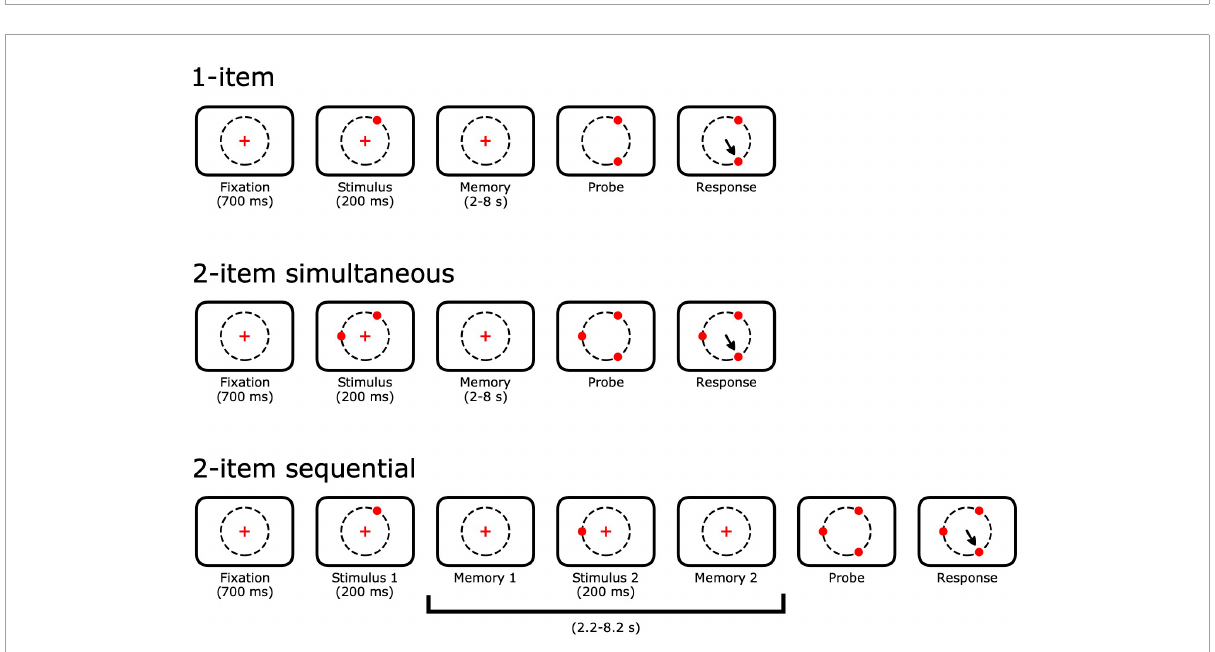
FIGURE2 Single- and multi-item spatial memory tasks. Trials begin with a 700 ms fixation of a central point. For n -item simultaneous trials, n peripheral targets appear 13 degrees of visual angle (dva) out from the fixation point. Animals continue to fixate through a variable delay period. For n -item sequential trials, a single target appears first and subsequent targets appear throughout the full delay. For all trial types, all of the previously shown peripheral targets reappeared at the end of the delay along with a single novel target. Animals received liquid rewards for making a saccade to the novel target. Delay period lengths were varied across sessions and ranged from 2 to 8